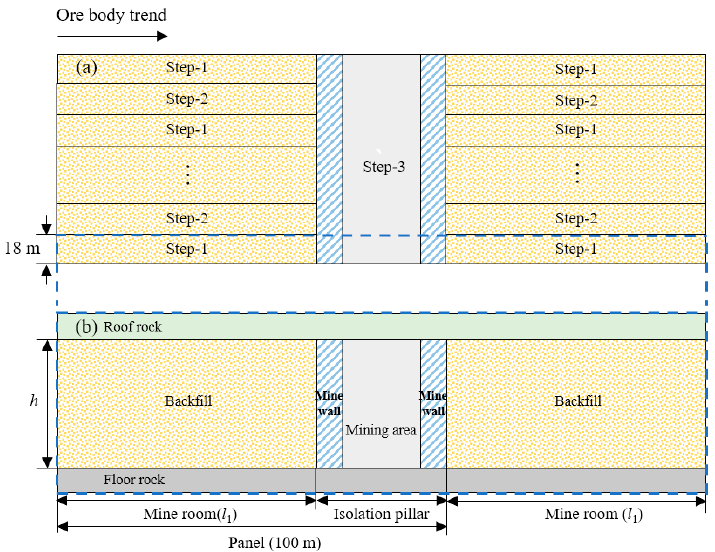
Figure 1. ( a ) Top view of Dongguashan stope layout. ( b ) Vertical cross section view of Dongguashan stope layout.